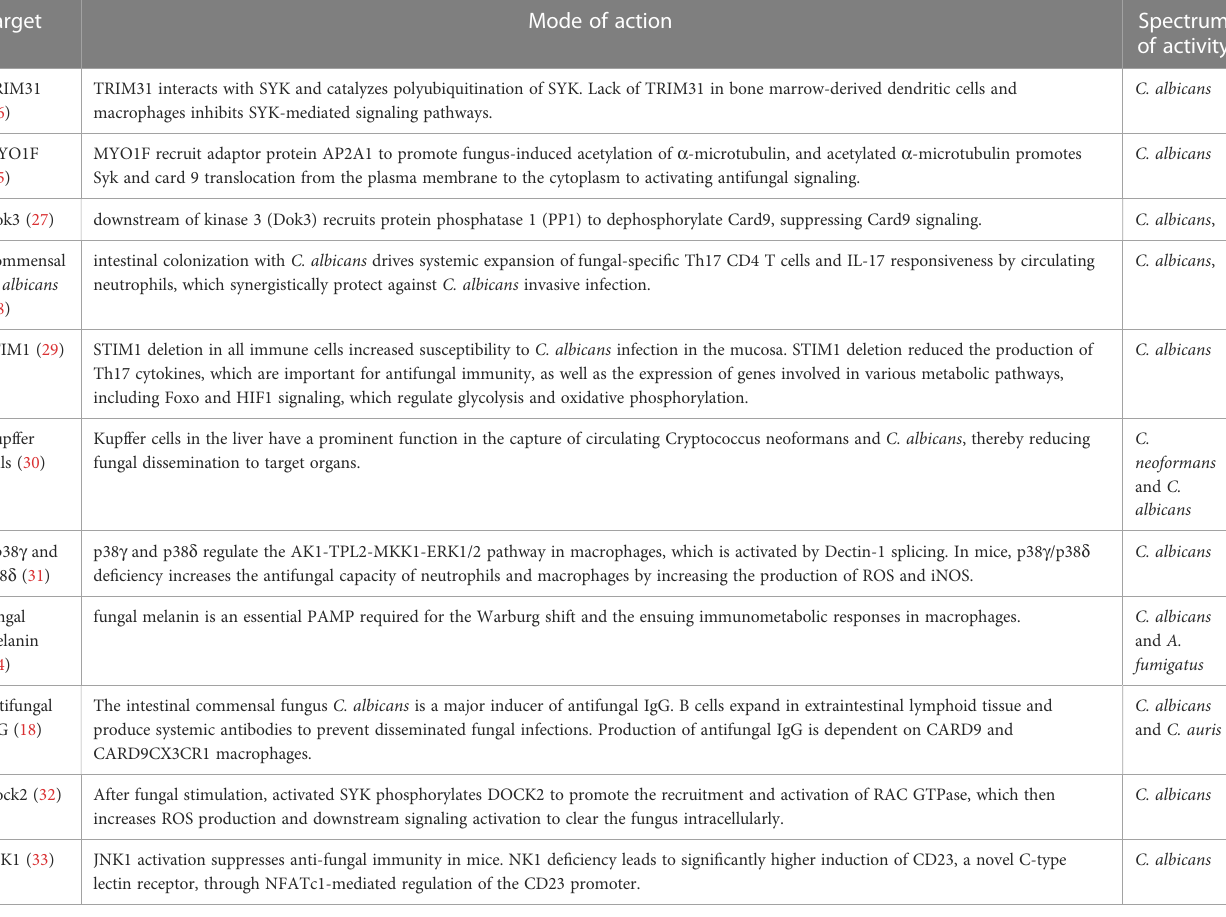
TABLE 1 Antifungal signaling pathways discovered in the last 5 years. Target